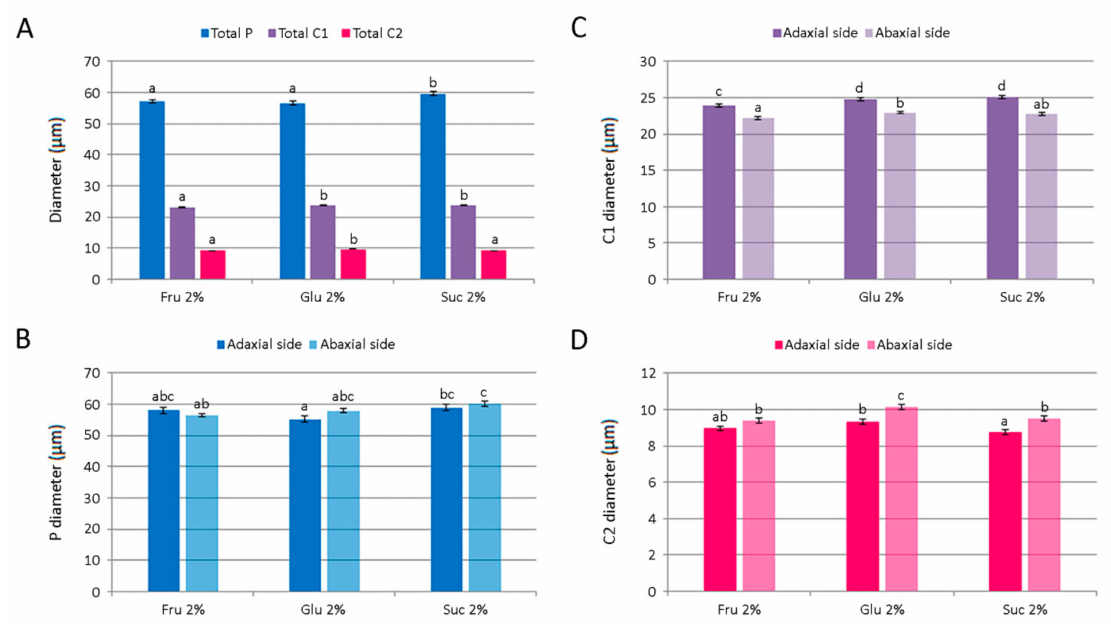
Figure 9. The size of glandular trichomes on leaves of Clinopodium pulegium plants cultured in vitro on medium supplemented with different carbohydrates at the concentration of 2%. ( A ) An average diameter of different trichome morphotypes of both epidermis surfaces. ( B ) Diameter of glandular head of peltate trichomes. ( C ) Diameter of the head and neck cell of type I capitate trichomes. ( D ) Diameter of the head cell of type II capitate trichomes. Values represent means ± SE, n = 24. Means within the same histogram marked with different letters are significantly different according to Tukey’s HSD test at p ≤